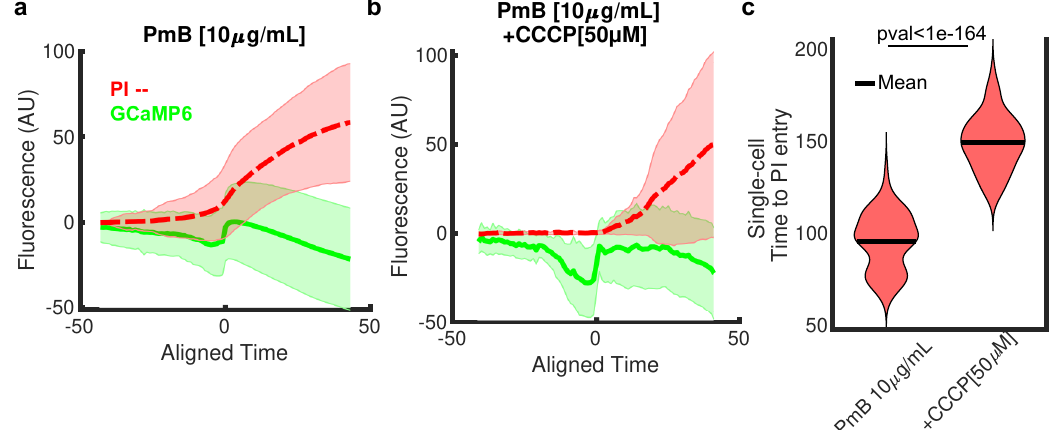
Figure 8. Polymyxin B induces three-phase Ca 2 + dynamics. ( a ) Time aligned GCaMP6 (green curve) and propidium iodide (PI, red dashed curve) traces in 10 µ g/mL Polymyxin B (PmB). Because the Ca 2 + blink does not happen simultaneously in all cells, we aligned the traces to the last time-point where the derivative of the GcAMP6 signal is 5 standard deviations above average after 150 min (Figure S8a). This point is Aligned Time = 0 in the plot. The GCaMP6 and PI signals from − 45 to +45 min of this point are included. Fluorescence is normalized to the average intensity of the signal between frames 10 and 20. ( b ) The GCaMP6 and PI traces with the addition of 50 µ M CCCP in 10 µ g/mL PmB treatment condition. ( c ) The distribution of time to PI entry in single cells for 10 µ g/mL PmB treatment with or without CCCP. PI entry was defined as the fluorescent signal 5 standard deviations above the mean signal over the first 40 frames. The p-value was calculated using a one-tail Mann–Whitney U test (null hypothesis: Median(+CCCP)<Median(-CCCP)). The presence of CCCP increases the mean time to PI entry (black lines) from 95 to 149 min. See Video